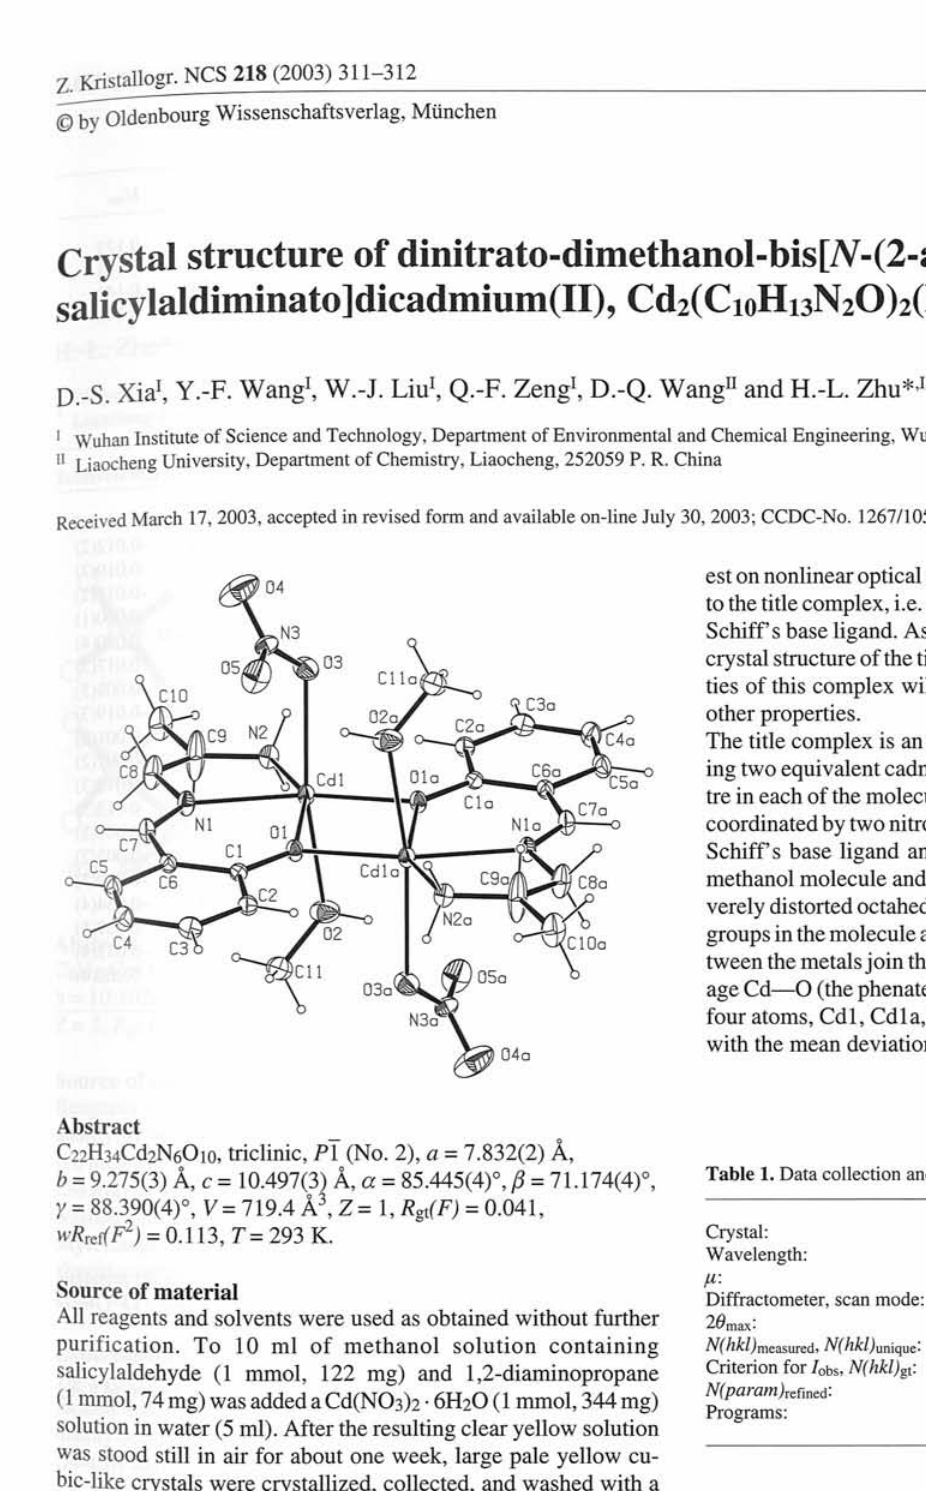
Table 2. Atomic coordinates and displacement parameters (in A